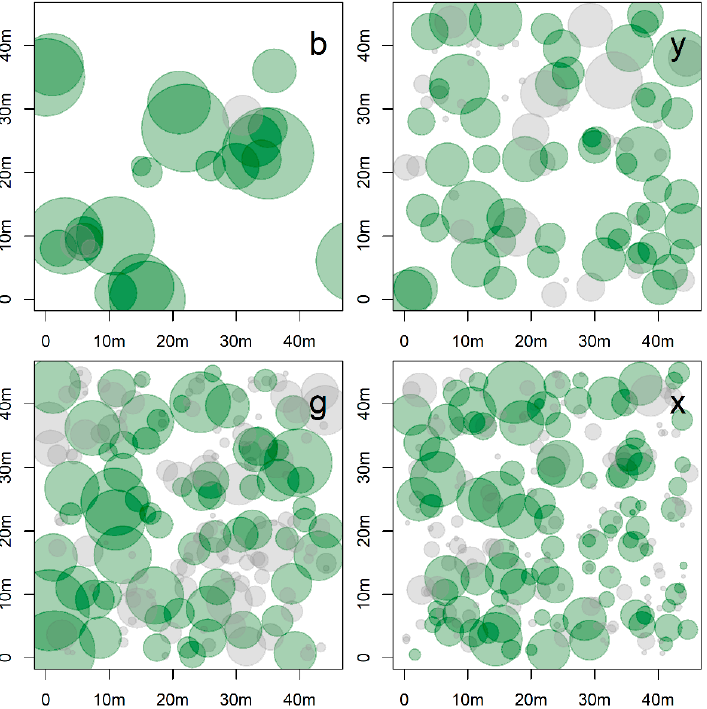
Figure 4. Spatial distribution of the tree diameters (DBH, ground data) in four of the studied plots, representing old-growth (corresponding to plots b and g ) and secondary forests (plots y and x ). The plots selected denote the highest and lowest tree density in each category. The size of the circle represents tree diameters and green circles represent trees effectively detected using unmanned aerial vehicle.